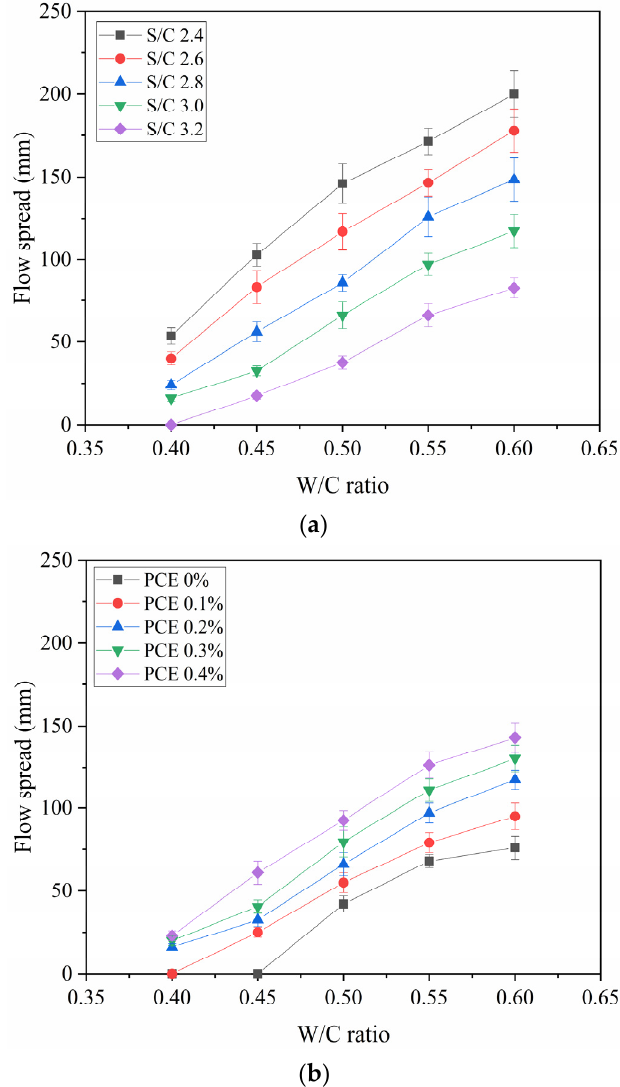
Figure 6. Flow Spread versus W/C Ratio: ( a ) different S/C ratios, ( b ) different PCE Dosages.